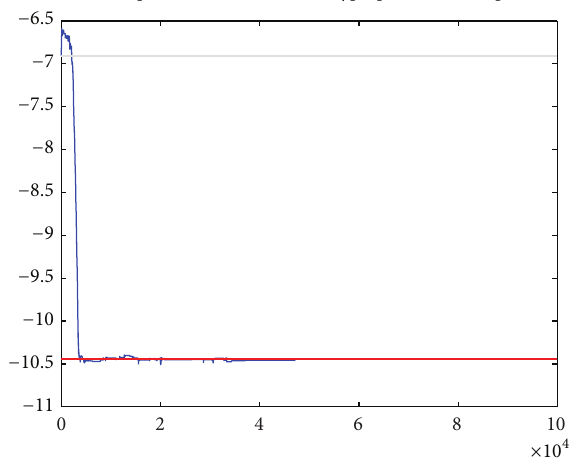
Figure 8: FFGP 2-factor 2-component likelihood noise hyperpa- rameter